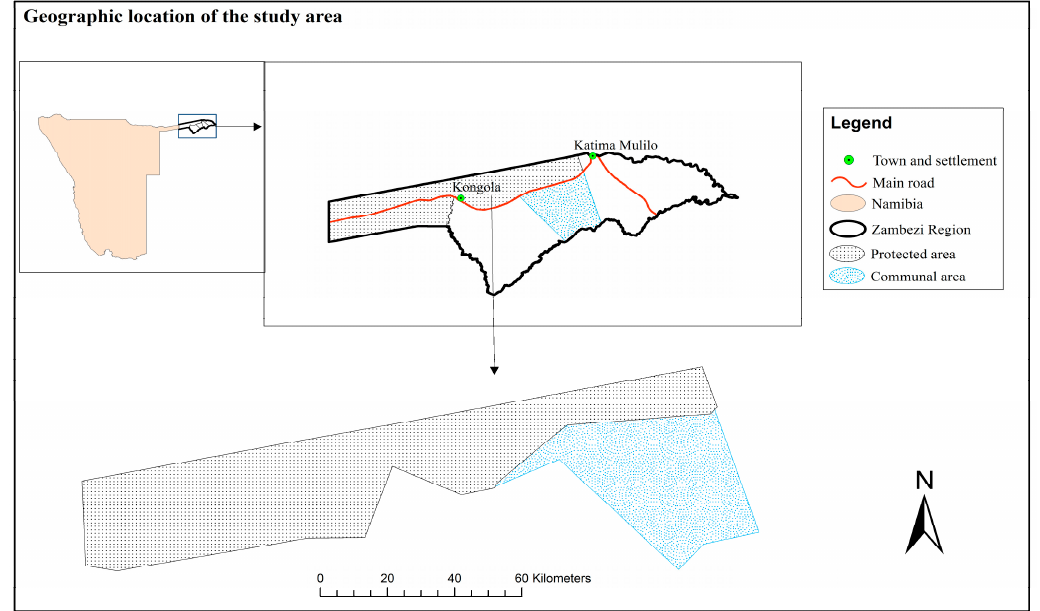
Figure 1. Location map of the study area (Source: [18]).